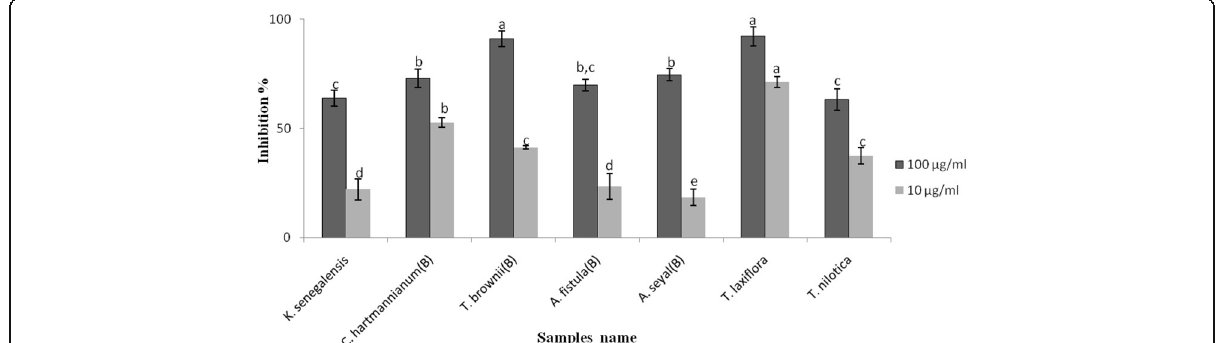
Fig. 1 Inhibitory activities of seven methanolic plants extracts against MMP-9. B: bark. NNGH as positive control has 100% inhibition at concentra- tion 100 μ g/ml. Values were expressed as mean ± SD, n = 3. Values not followed by a common letter were significantly different at the level ( p <